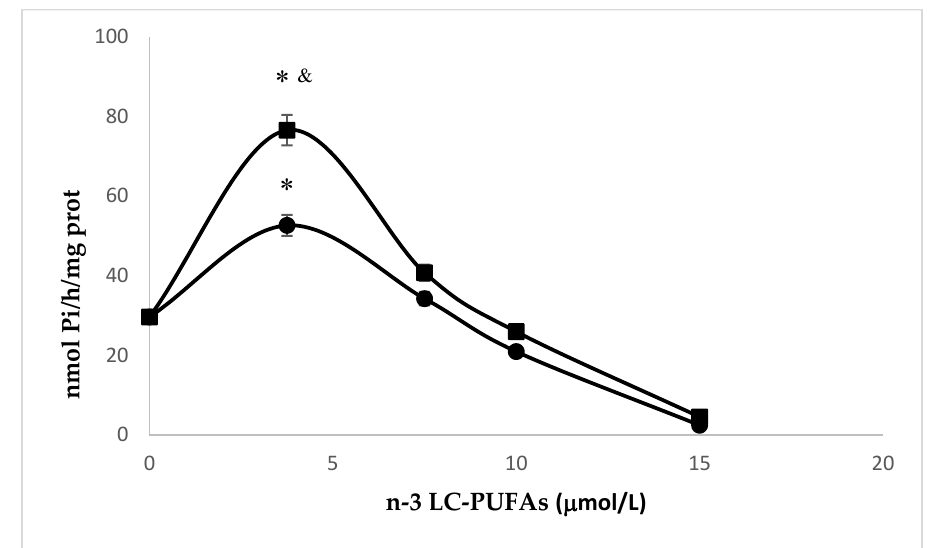
Figure 5. Effect of the incubation with increasing amounts of EPA (●) or DHA ( ∎ ) on Na,K-ATPase activity of HMEC. Experiments were performed in triplicate. Data are expressed as mean ± SD of replicates. The incubation of HMEC for 24 h with 3.75 μM of n-3 LC-PUFAs significantly increased pump activity when compared to basal levels and the other concentrations (*, p < 0.001, Student’s t test). DHA vs. EPA, p < 0.001, Student’s t test ( & ).